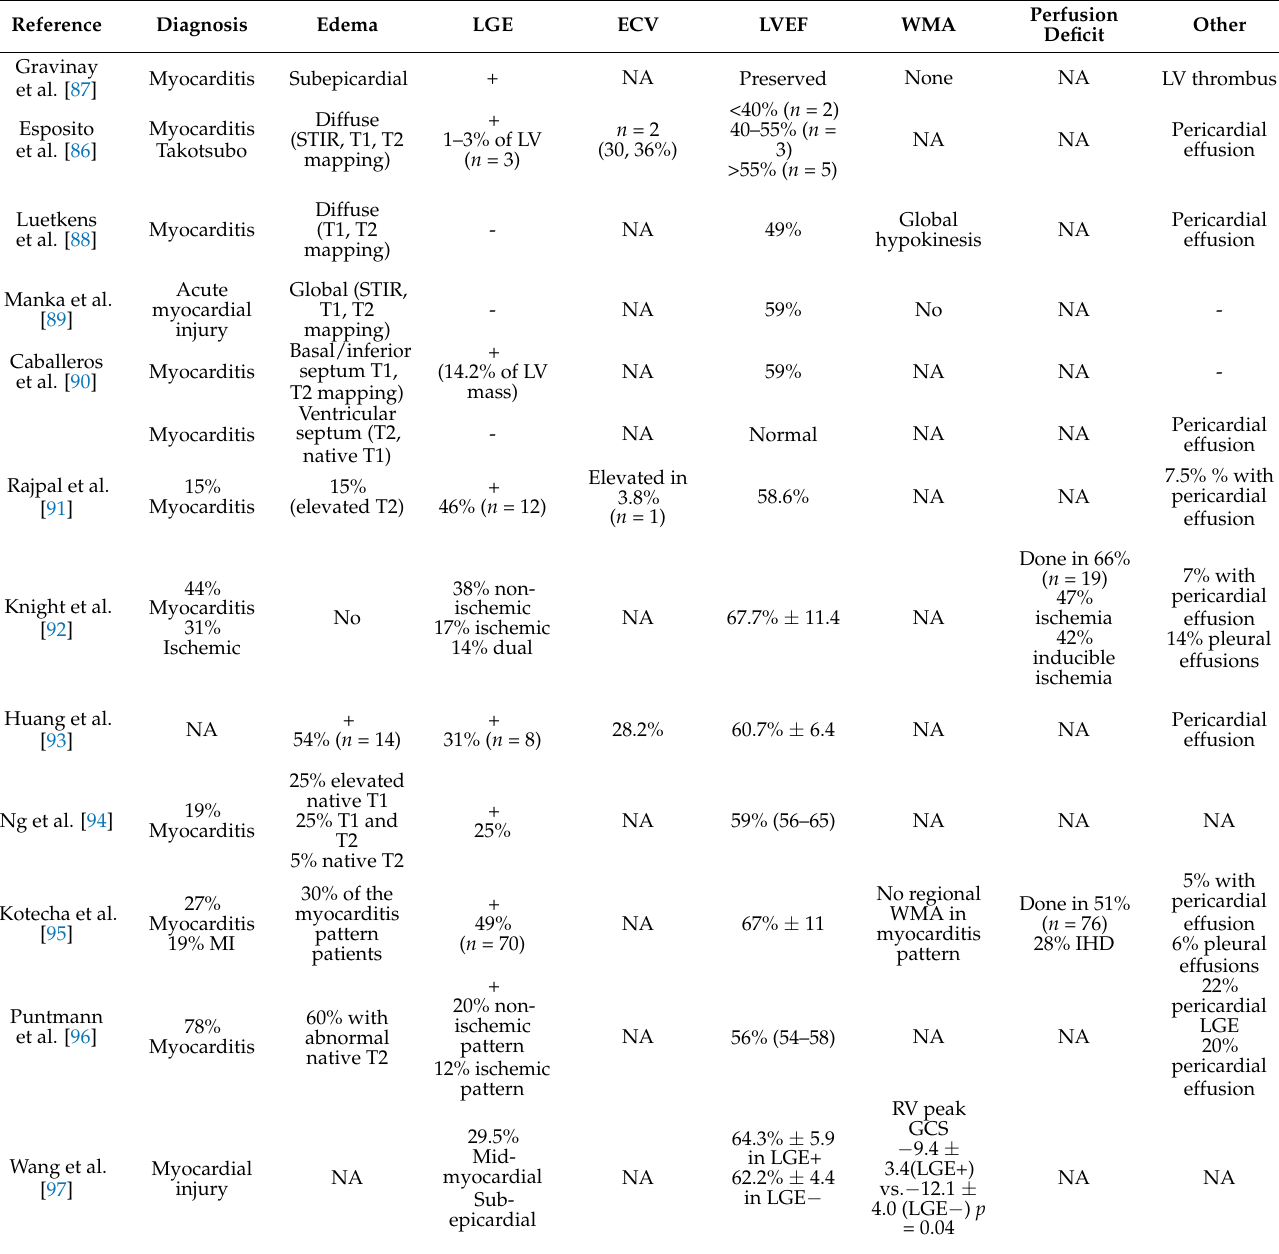
Table 2. CMR findings of the main studies on myocardial involvement in COVID-19.